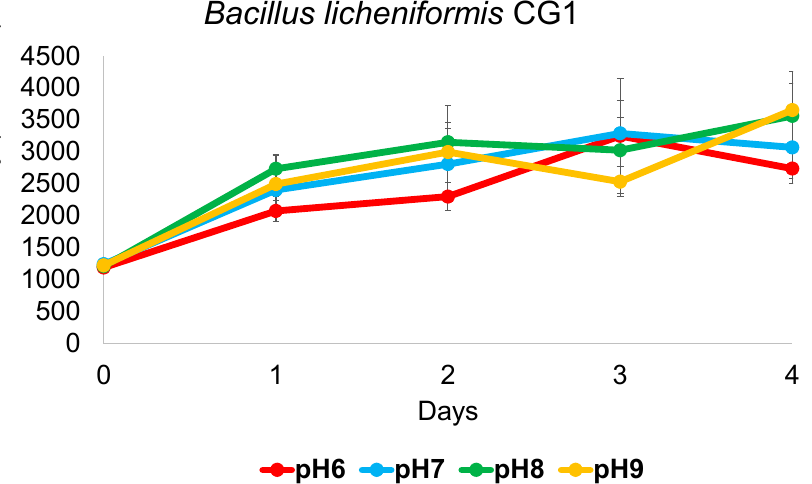
Figure 5. Keratinase activity of B. licheniformis CG1 across a range of pH. Cultures grown at 37 °C and 150 rpm for 4 days in 120 mL bottles hermetically closed showed similar keratinase activity in a medium adjusted to varying pH values and where chicken feathers were the sole carbon and nitrogen source. Vertical error bars correspond to the standard error of the mean of three replicated experiments.